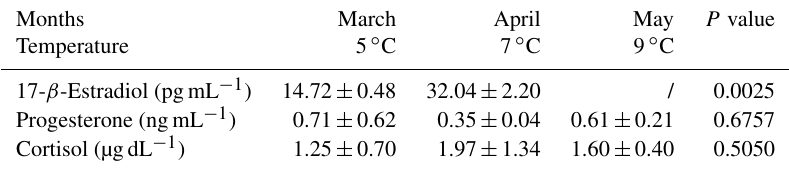
Table 2. Seasonal circulating 17- β -estradiol, progesterone, and cortisol concentrations (mean ± SD) in 30 non-pregnant Nicastrese